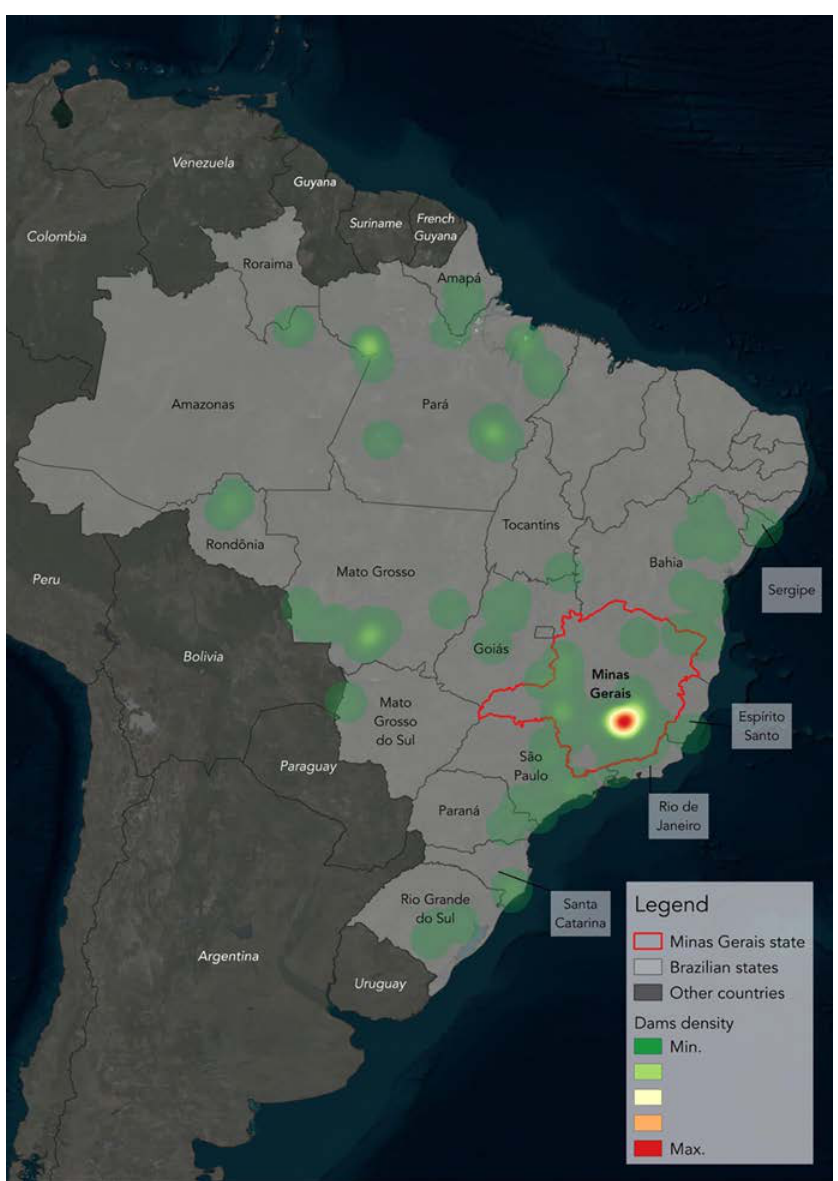
Figure 1. Density of dams in Brazil, highlighting the state of Minas Gerais Source: the author, with data from National Mining Agency (2019)